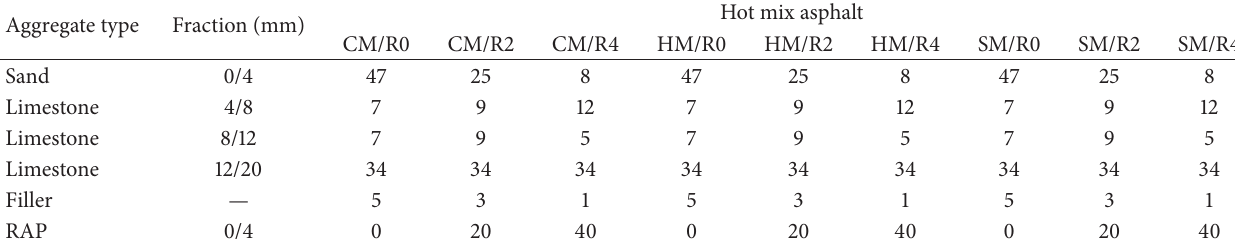
Table 3: Aggregate composition of the hot mix asphalt.